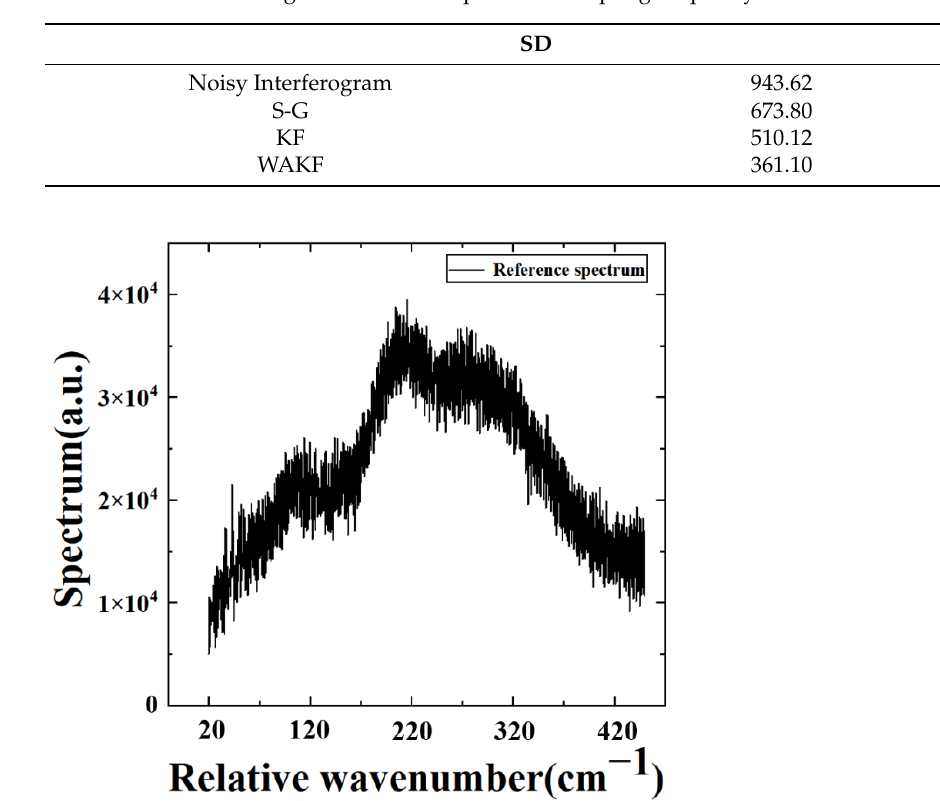
Figure 6. Amplitudes of the interferogram as a function of sampling points for the 355th pixel at a sampling frequency of 125 MHz. Table 2. SD for interferogram of the 355th pixel at a sampling frequency of 125 MHz.